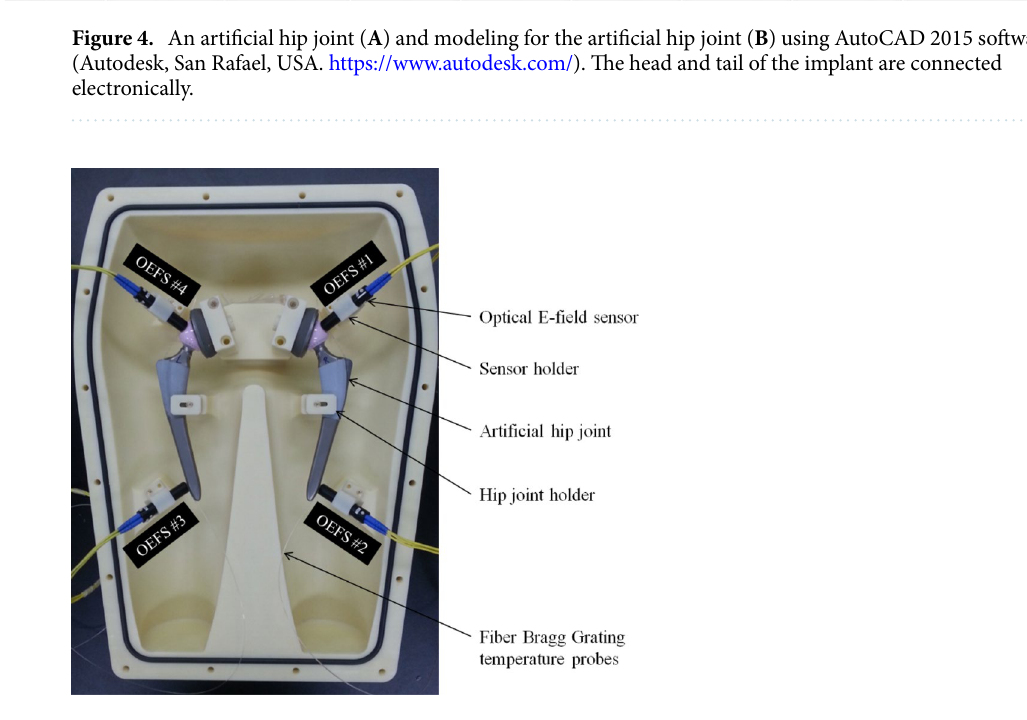
Figure 5. Locations of four optical E-field sensors (OEFS) and two optic-fiber Bragg grating (FBG) temperature sensor arrays on the surface of the artificial hip